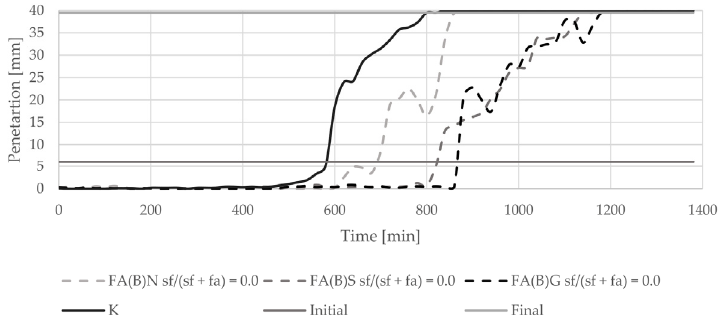
Figure 6. Setting time results of cement pastes with biomass fly ash activated by sieving or grinding.